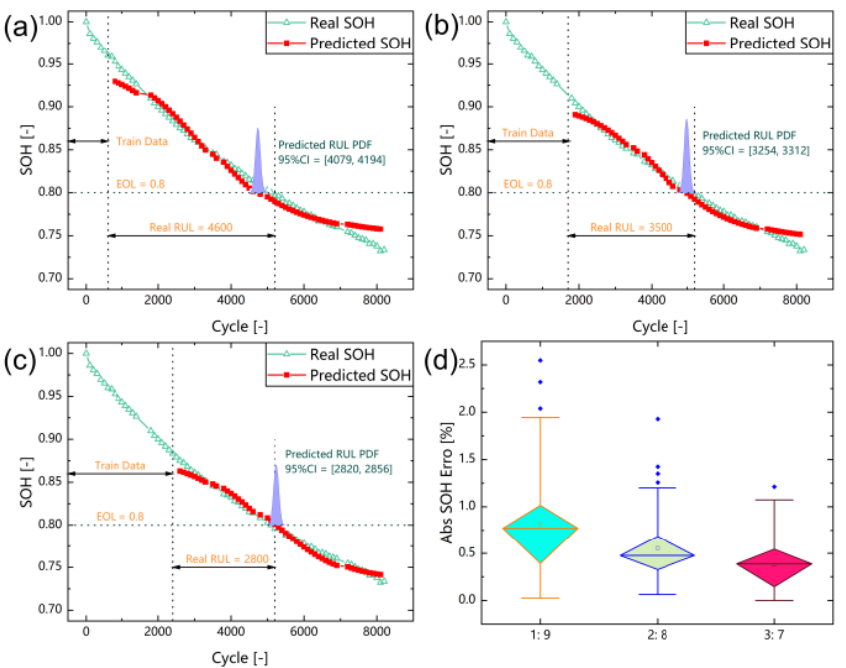
Figure 9. Validation of early SOH and RUL estimation ability of the proposed model. ( a ) Estimation results for battery #1 with split portion of 1: 9. ( b ) Estimation results for battery #1 with split portion of 2:8. ( c ) Estimation results for battery #1 with split portion of 3:7. ( d ) Box-plot analysis for battery #1 for three proportions.